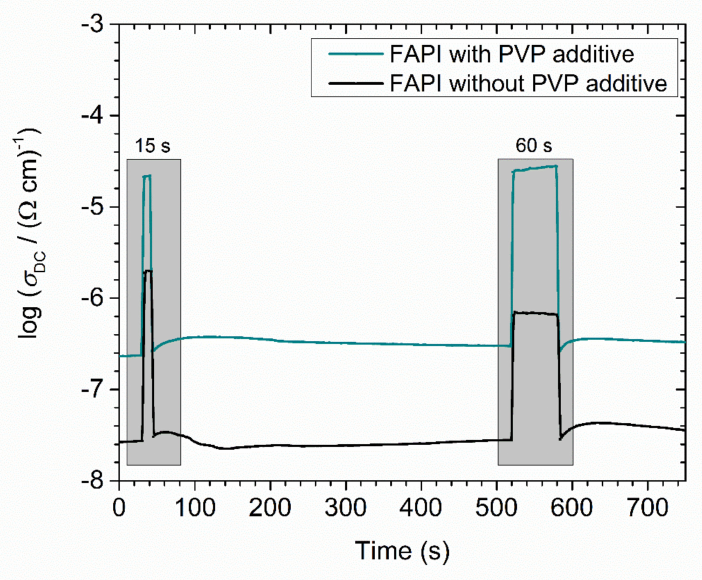
Figure 13. Photoconductivity measurements at 1 Hz after 15 and 60 s exposure to 1 Sun for FAPI perovskite thin film with and without PVP additive on ZNR/glass